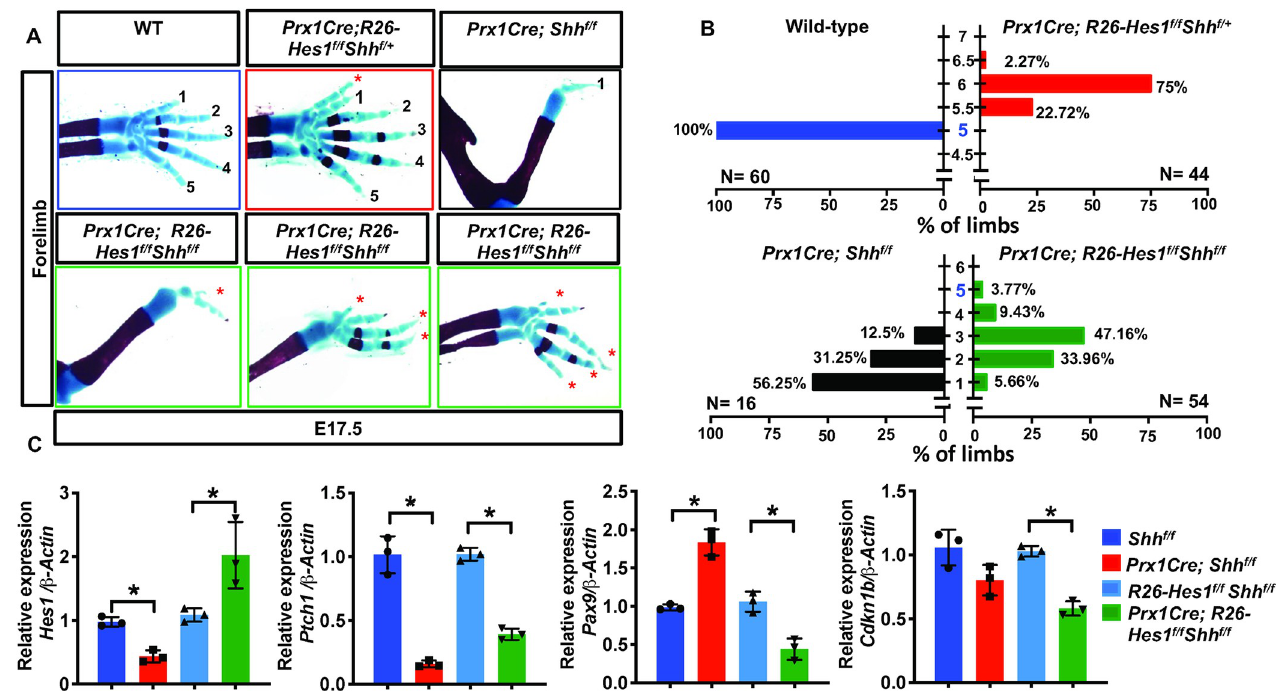
Fig 6. Hes1 over-expression within limb bud mesenchyme is sufficient to overcome the digit loss observed in SHH LOF limbs. (A) Alcian Blue/Alizarin Red staining of WT, Prx1Cre; R26-Hes1 f/f ; Shh f/+ (HES1 GOF), Prx1Cre; Shh f/f (SHH LOF), and Prx1Cre; R26-Hes1 f/f ; Shh f/f (SHH LOF/HES1 GOF) double mutant forelimbs. Red asterisks indicate HES1-induced digits (B) Quantification of digit numbers for WT (n = 60), HES1 GOF (n = 44), SHH LOF (N = 16), and SHH LOF/HES1 GOF (n = 54) forelimbs ( χ 2 test) (p-value < 0.0001). Y axis represents the number of digits whereas the x-asix represents the percent of the forelimbs. Intervals of 0.5 represent syndactylous digits. (C) qPCR for Hes1 , Ptch1 , Gli1 , Pax9 , and Cdkn1b performed on RNA from Shh f/f (Control), Prx1Cre; Shh f/f (SHH LOF), R26-Hes1 f/f ; Shh f/f (Control), and Prx1Cre; R26-Hes1 f/f ; Shh f/f (SHH LOF/HES1 GOF) limb buds at E11.5 (N = 3). Each data point represents separate animals. Asterisks indicate significance with a p-value < 0.05 (One-way ANOVA).